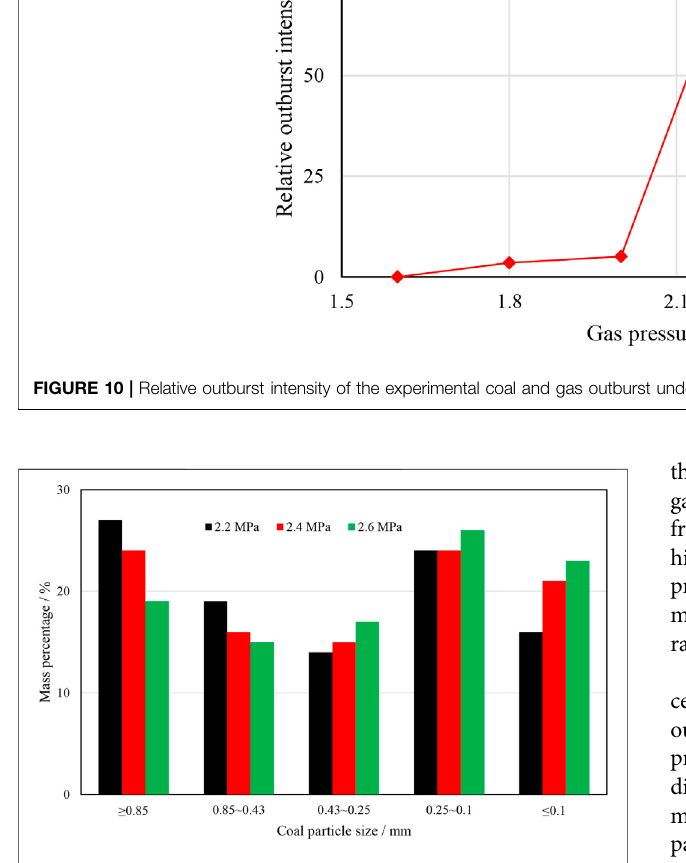
FIGURE 11 | Mass proportion distribution of the ejected pulverized coal under different gas pressures from 2.2 to 2.6 MPa. Since there is no coal ejected at a gas pressure from 1.6 to 2.0 MPa, the results is no